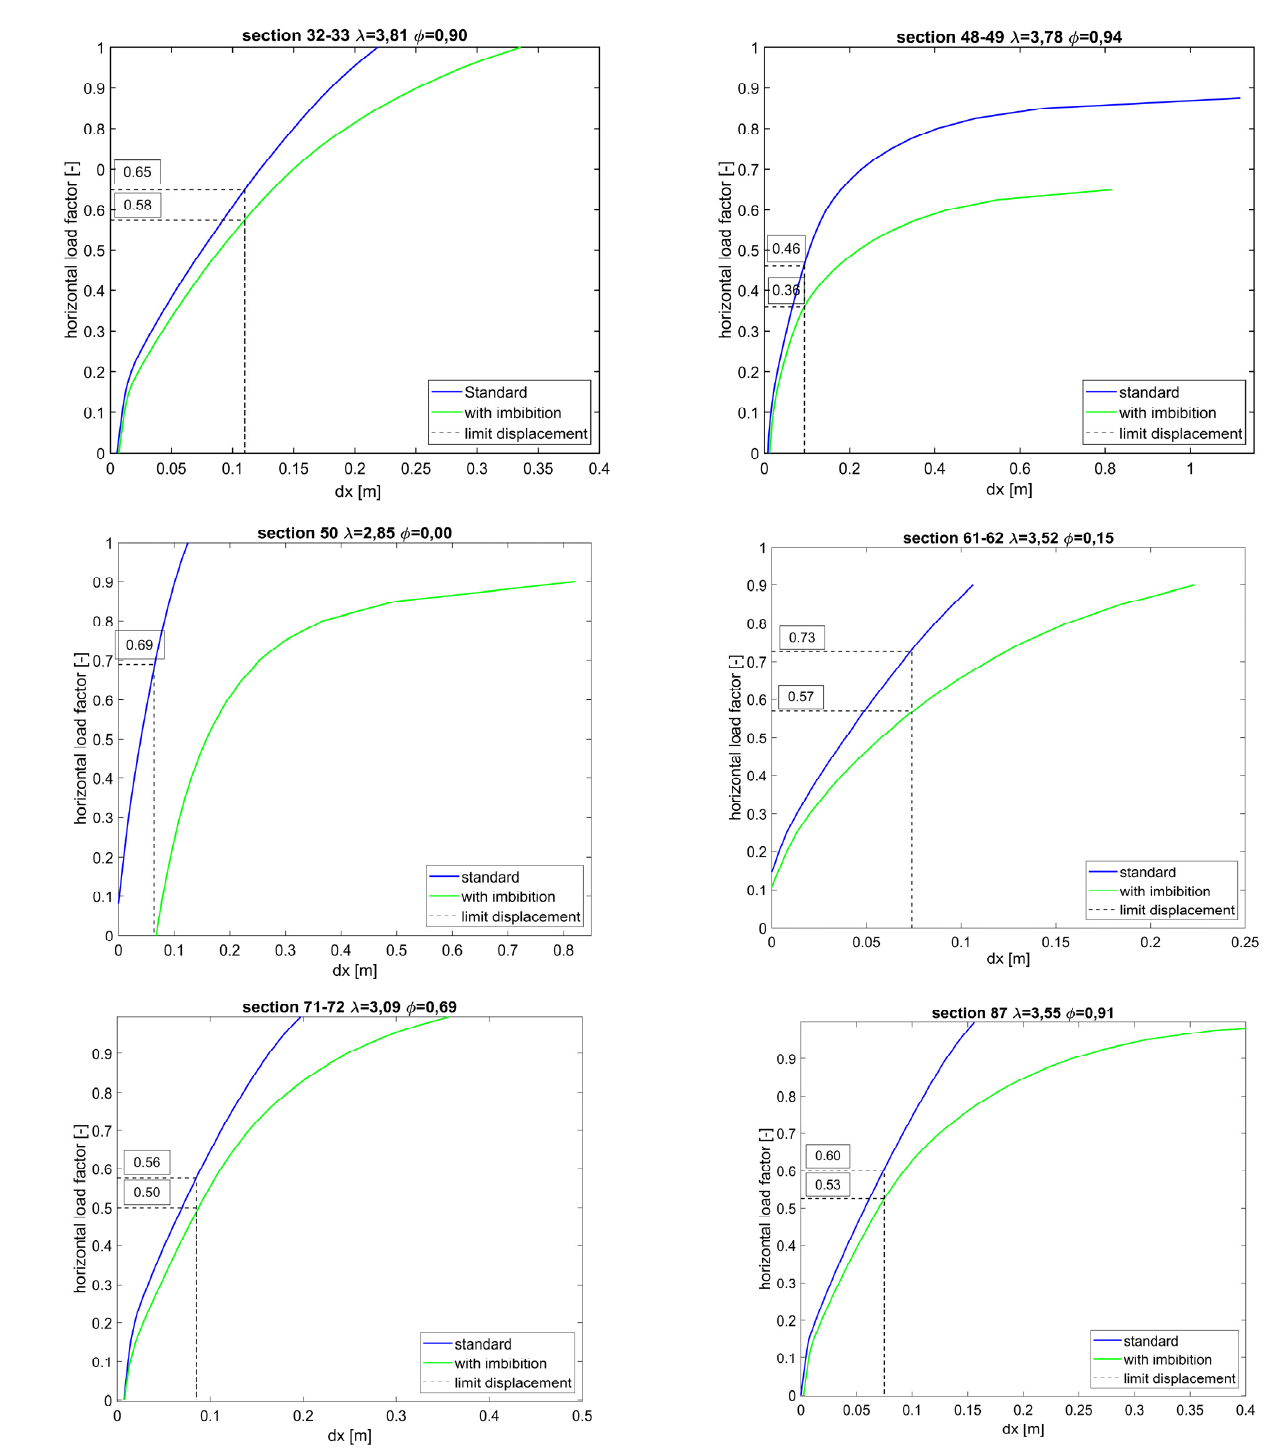
Figure 8. Push over curves for the examined sections. The ultimate displacement in the case of imbibition ( μ i ) can be related to the ultimate displacement in the case of a dry section ( μ d ) using Equation (9), with Δ μ being the dis- placement ratio at failure. The results are listed in Table 5 and show that μ i was generally higher than μ d . Δ𝜇 = (cid:3091) (cid:3284) (cid:2879)(cid:3091) (cid:3279) (cid:3091) (cid:3279)